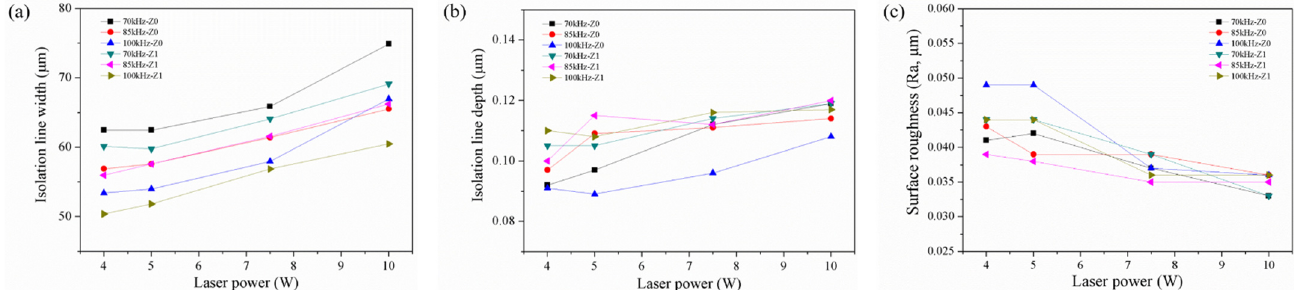
Figure 6. Relationship between the laser power and ( a ) isolation line width, ( b ) isolation line depth, and ( c ) surface roughness of PC within the isolation line.